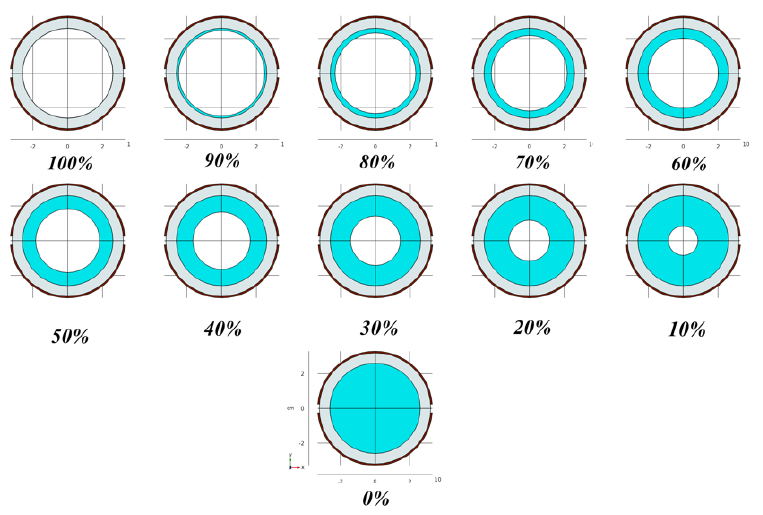
Figure 8. ( a ) 3-Dimensional view of the electrodes pattern. ( b ) Volumetric view the simulated setup. ( c ) Meshed model of the simulated structure.